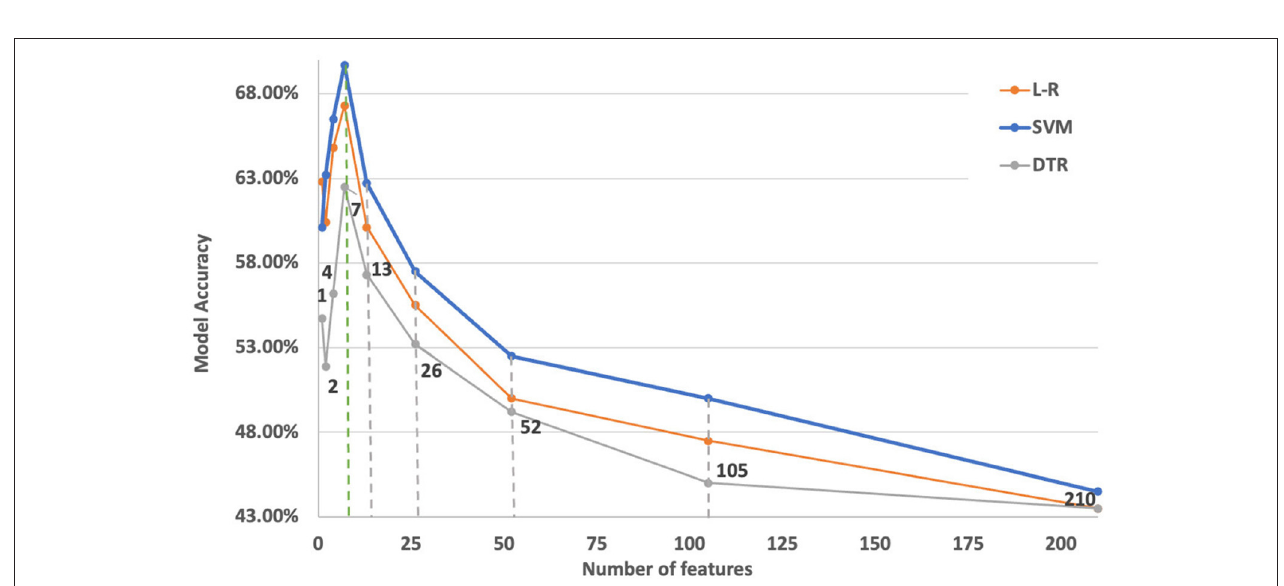
FIGURE 2 | The number of components removed across all 48 subjects for “Rest” and “Simkap” task load conditions.